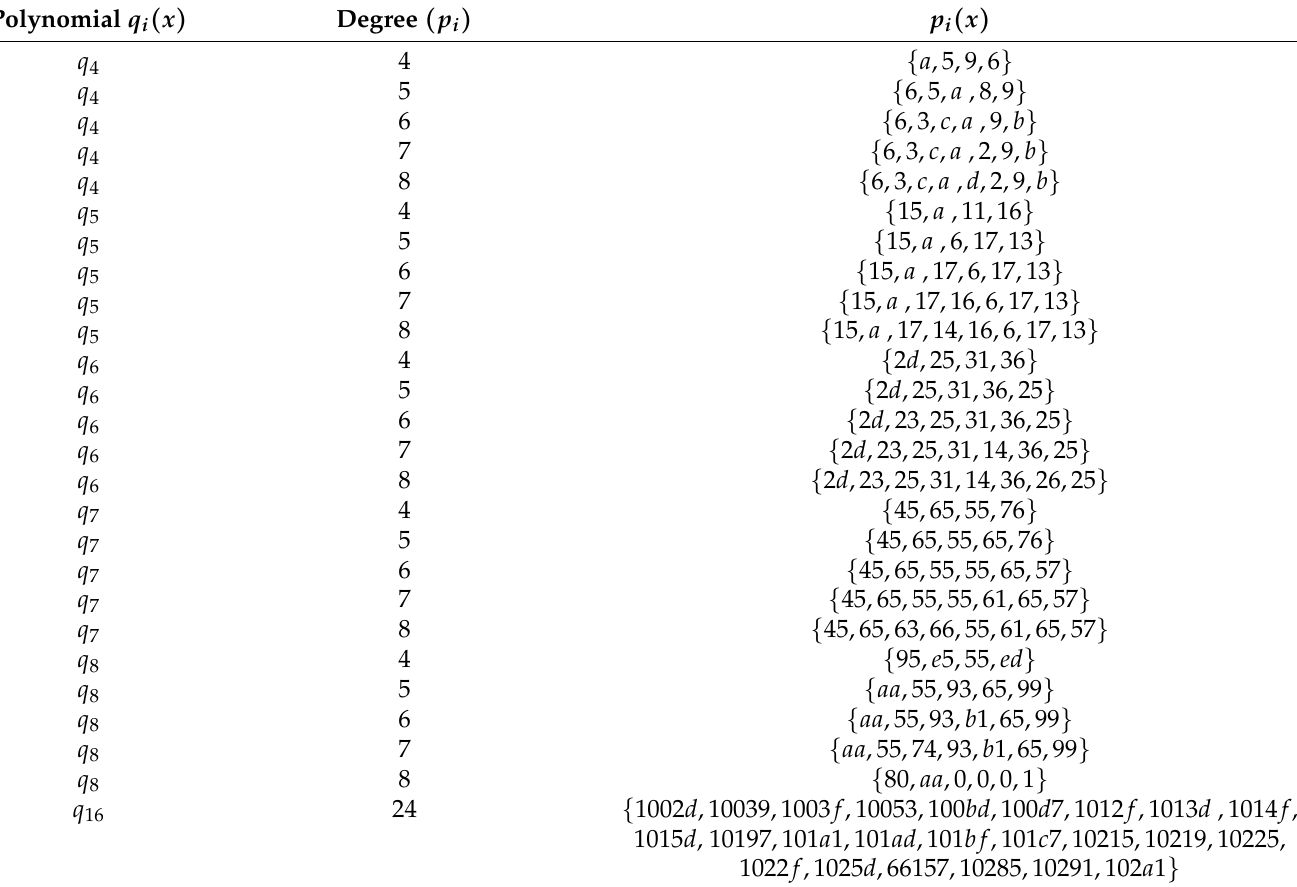
Table 4. List of primitive polynomial used for the extended field generated by each q i ( x ) .